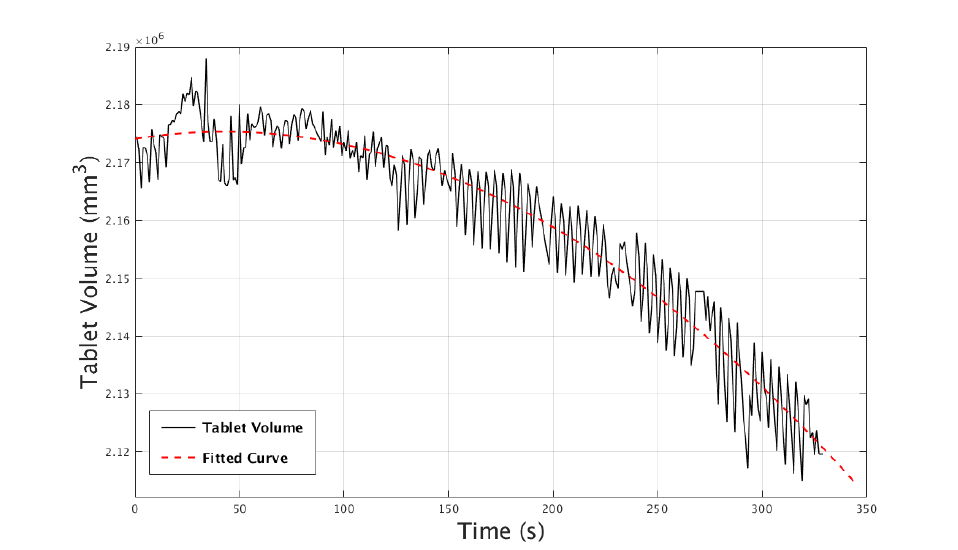
Figure 15. The decline in tablet volume over the 5-minute data acquisition period.